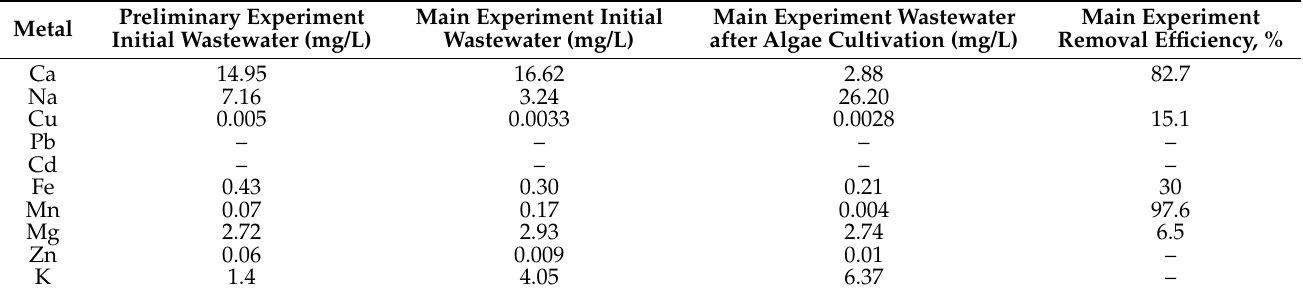
Table 3. Content of metal ions in wastewater with removal efficiency rates during the main experi- ment.